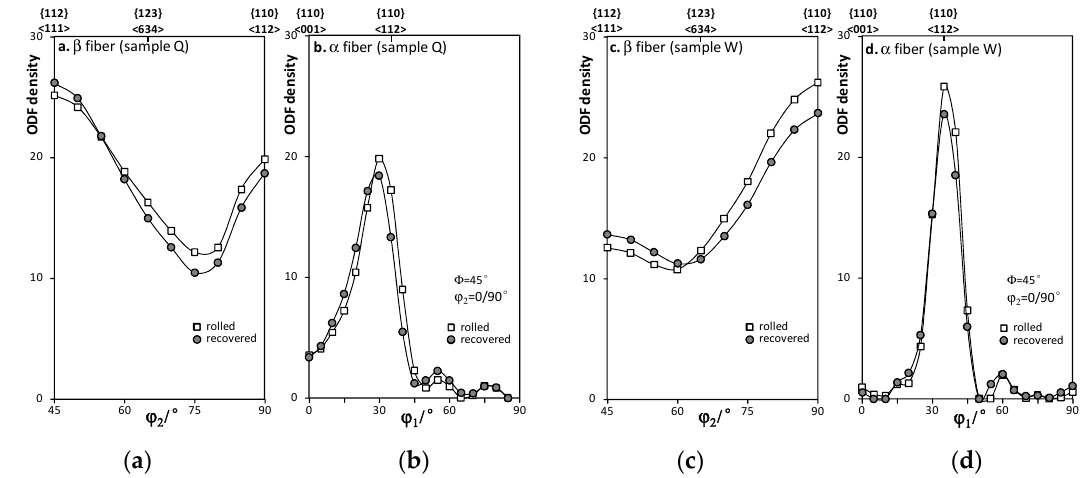
Figure 6. ODF fiber analysis of texture in 95% rolled and recovered aluminum sheets. ( a ) β -Fiber of sample Q; ( b ) α -fiber of sample Q; ( c ) β -fiber of sample W; ( d ) α -fiber of sample W.